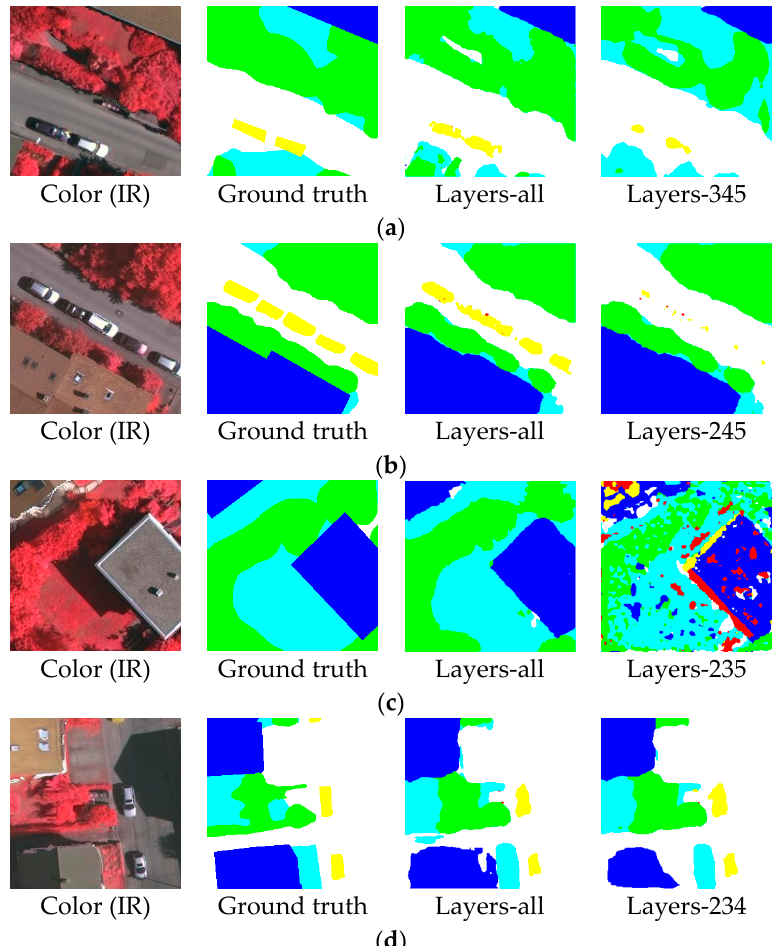
Figure 4. The contribution of layers 2, 3, 4 for different classes in images: ( a ) When layer 2 is removed, half of the trees in the scene are classified as low vegetation; ( b ) without layer 3 cars are mostly not detected anymore; ( c ) when layer 4 is removed, the results are cluttered. However, adding layer 4 eliminates clutter; ( d ) without layer 5 parts of buildings are not detected. (White = impervious surface; dark blue = building; green = high vegetation; cyan = low vegetation).